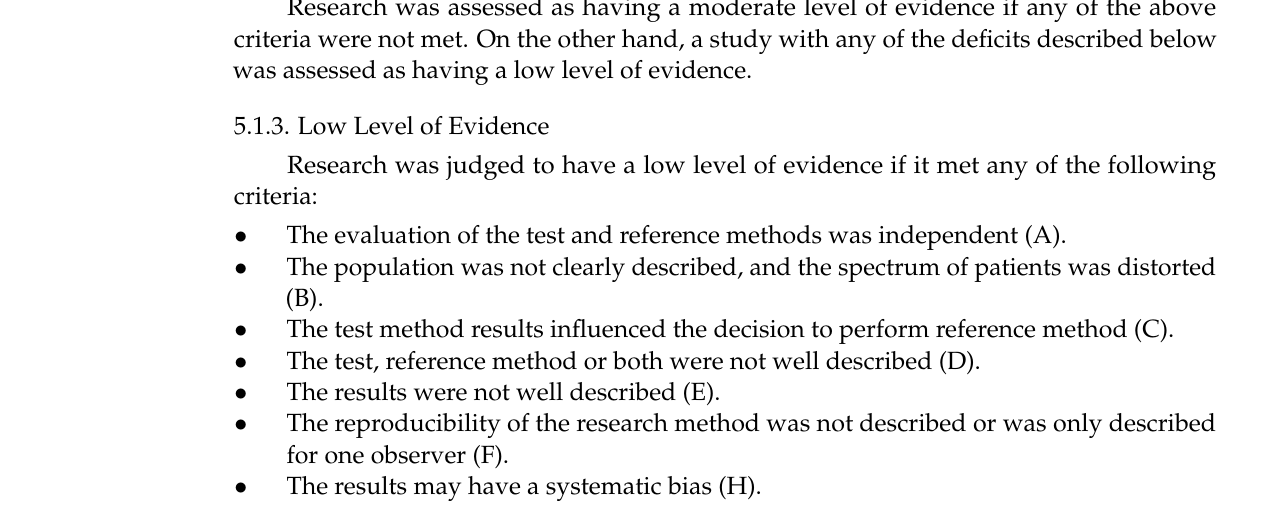
Level of evidence Level of evidence Yellow — moderate level of evidence, Green — low level of evidence. Yellow — moderate level of evidence, Green — low level of evidence. Yellow — moderate level of evidence, Green — low level of